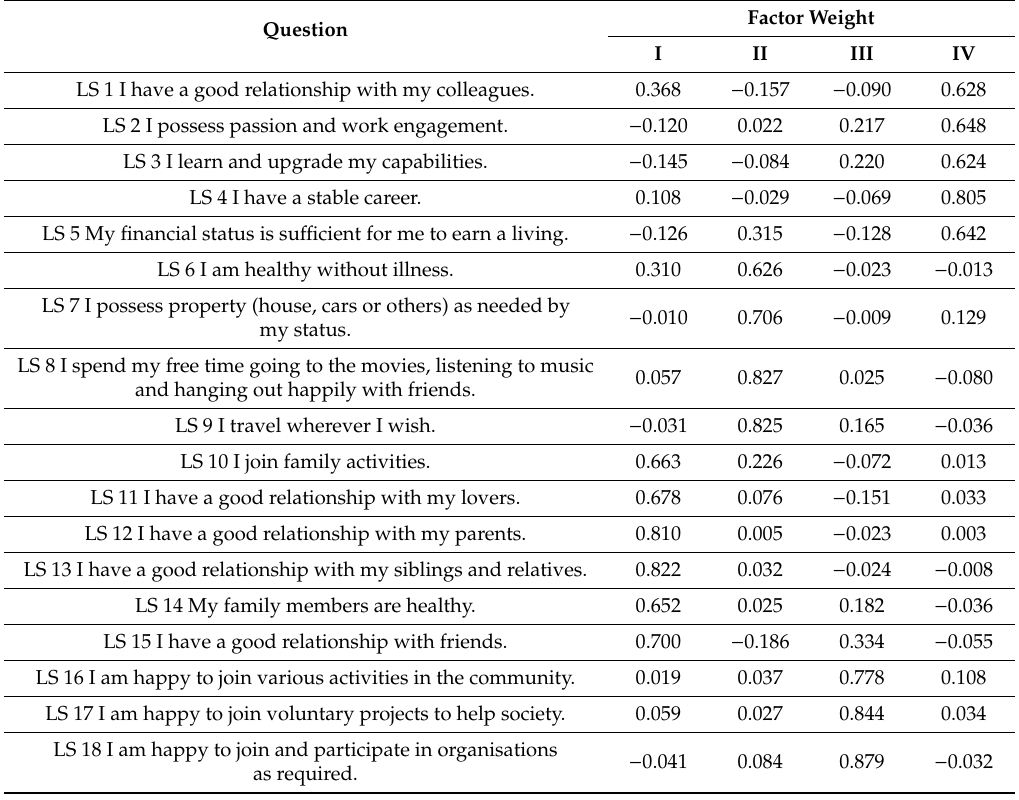
Table 2. EFA results of the LS